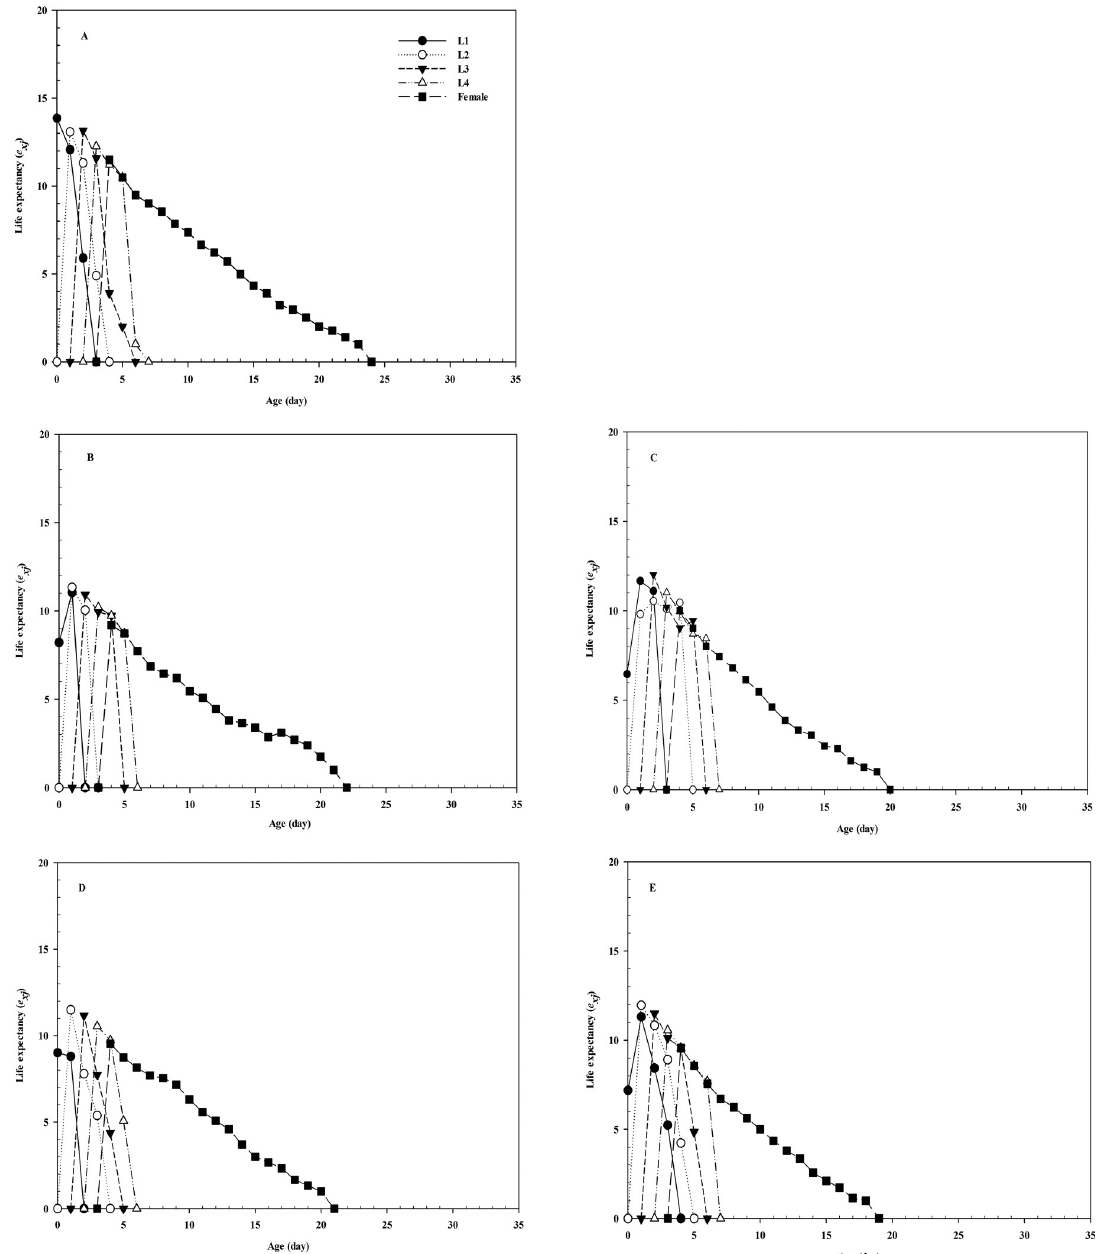
Fig 4. Life expectancy ( e xj ) of A . glycines . The e xj of A . glycines in the control (A), LC 30 imidacloprid (B), LC 50 imidacloprid (C), LC 30 thiamethoxam (D), and LC 50 thiamethoxam (E) groups. L1 = e of the third instar nymphs; and L4 = e xj of the fourth instar nymphs.